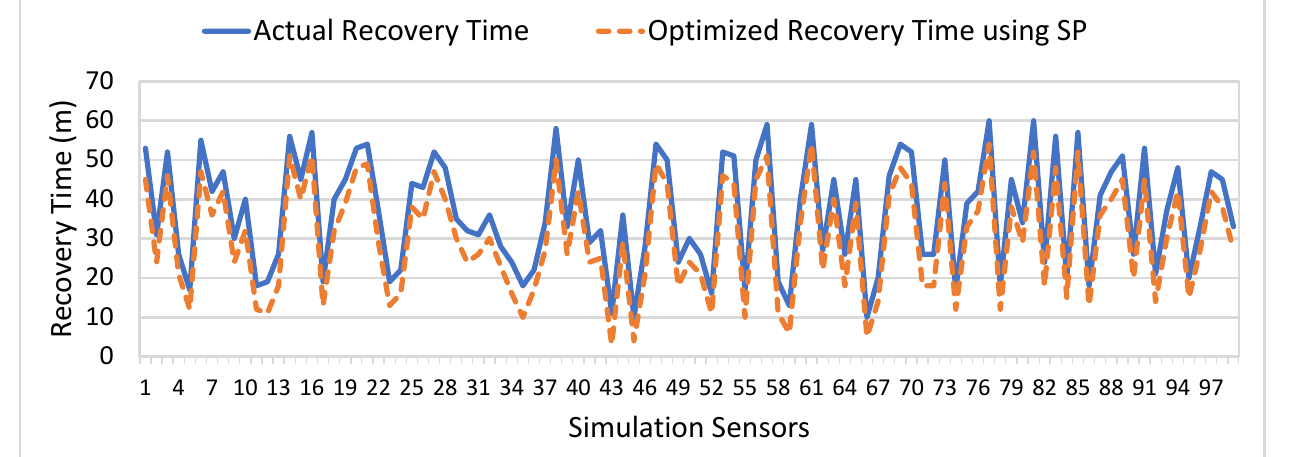
Figure 12. Comparative Analysis of Actual and Optimized Sensors Failure Recovery Time